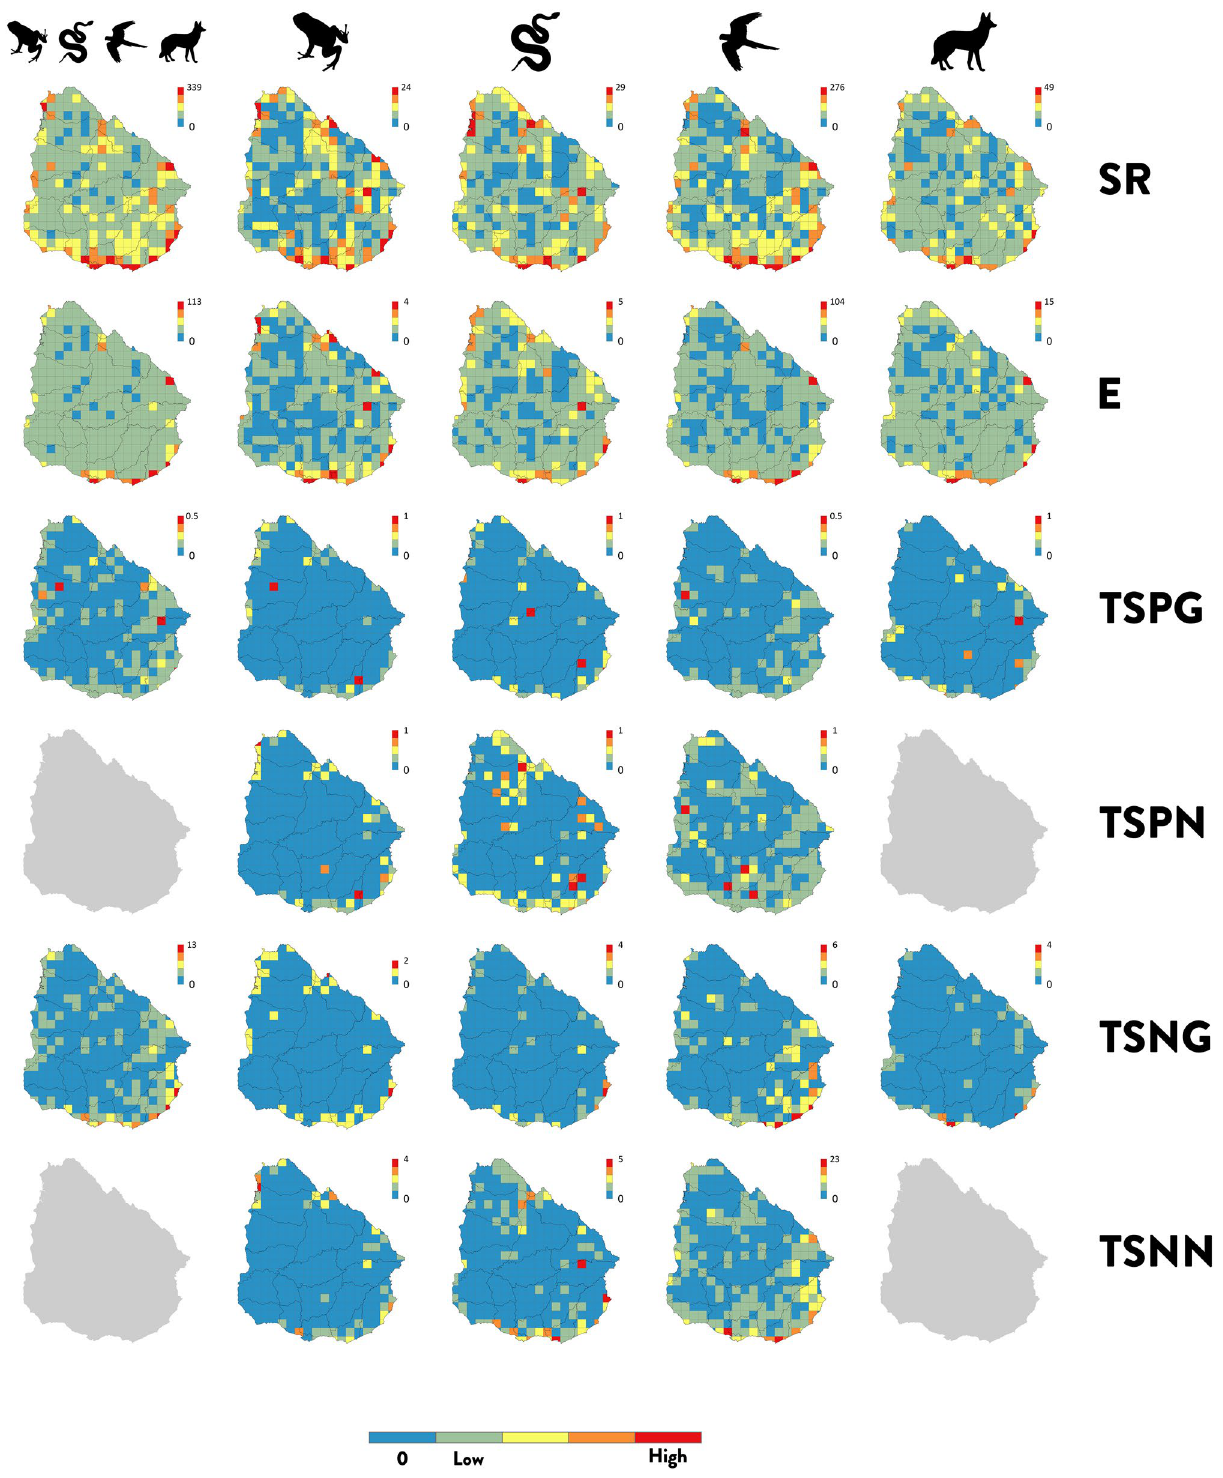
Figure 1. Spatial distribution patterns of hotspots of tetrapod species in Uruguay. Hotspots metrics for all tetrapods, amphibians, reptiles, birds and mammals (from left to right), of species-richness (SR) (top row), endemism (E) (second from the top row), threatened species proportion using the global IUCN assessment (TSPG) (third row) or national IUCN assessment (TSPN) (forth row), and threatened species number using the global IUCN assessment (TSNG) (fifth row) or national IUCN assessment (TSNN) (bottom row). Blue cells indicate either non-sampled areas or zero values of threatened species for both relative and absolute estimates. Because of lack of mammals’ threat assessment, values for mammals and tetrapods at national level could not be computed (grey maps are shown). Scale bar values differ between panels depending on the hotspot’s metric, top values are shown for each. All maps in 25 × 25 km grid-cell resolution. Projection WGS1984. Maps generated using ArcGIS 10.6 (https ://deskt op.arcgi